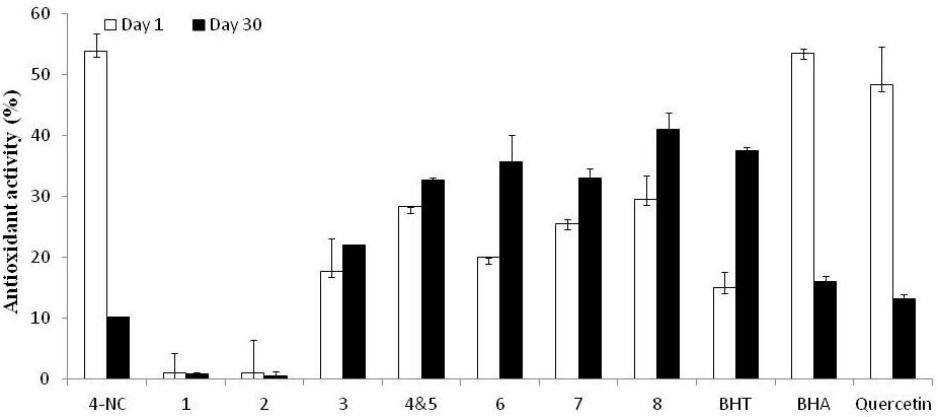
Figure 2. Antioxidant activity of DMSO solutions of 4-NC, 4-NC derivatives and control standards in the 3T3L1 mouse embryonic fibroblast cell line on day 1 and after storage at −20 °C for 30